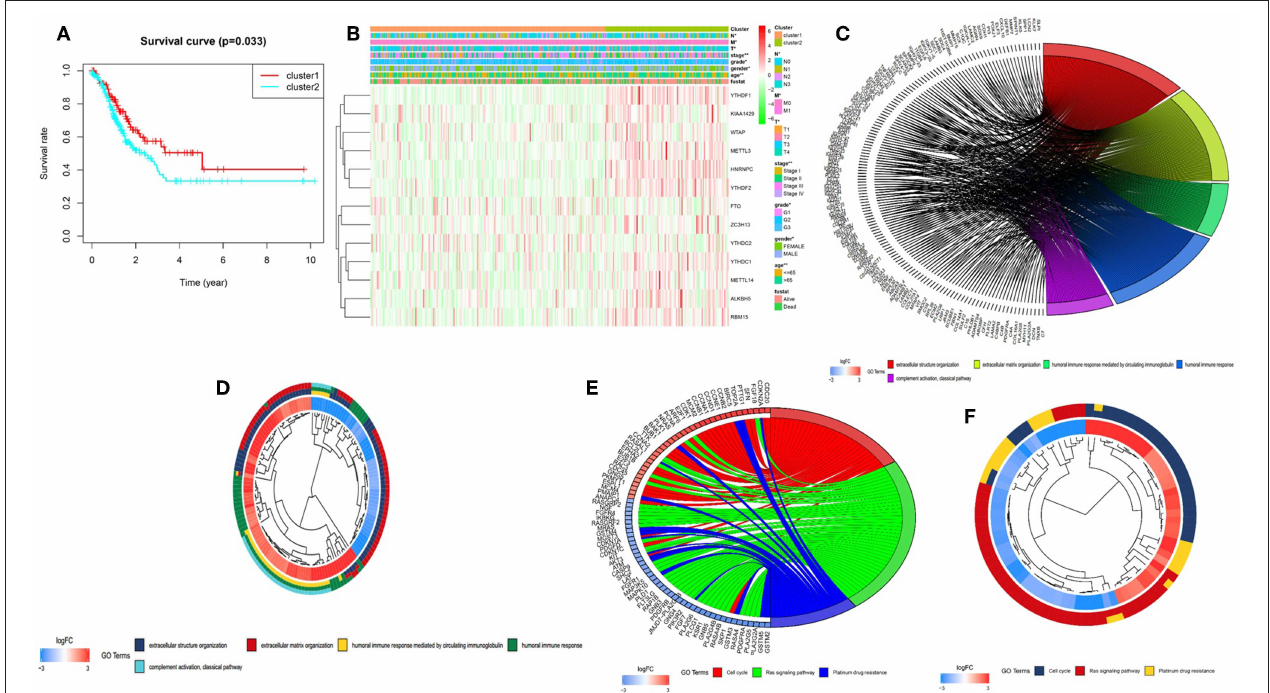
FIGURE 3 | Differential clinicopathological features and overall survival of gastric cancer in the cluster 1/2 subgroups. (A) Kaplan–Meier overall survival (OS) curves for 375 TCGA gastric cancer patients. Gastric cancer patients in the cluster1 subgroup are marked with red, and the cluster2 subgroup are marked with blue. (B) Heatmap and clinicopathologic features of the two clusters (cluster1/2) defined by the m 6 A RNA methylation regulators consensus expression. The higher or lower the expression, the darker the color (red is up-regulated and green is down-regulated). The upper tree diagram represents clustering results for different samples from different experimental groups, and the left tree shows cluster analysis results for different genes from different samples. (C–F) Functional annotation of the genes with higher expression in the clusters 2 subgroup using GO terms of biological processes (C,D) and KEGG pathway (E,F) . * P < 0.05, ** P < 0.01.